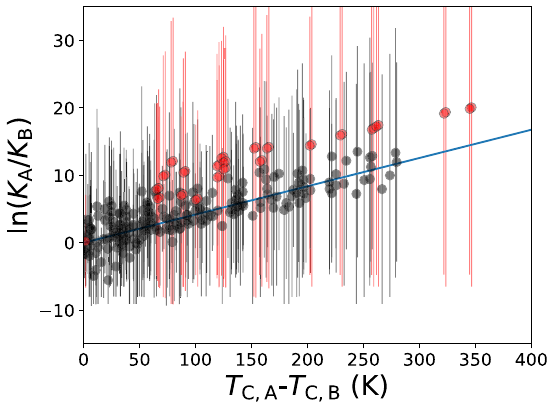
Fig. 7 Correlation for the typical selectivity of binary pairs. Selectivity is calculated as the ratio of Henry ’ s constants obtained from Widom insertion with the critical temperature of each adsorbate (blue). Values shown in red are for adsorbate pairs that contain either octanal or octan-1-ol and have been omitted from the fi tting procedure. The slope of the linear fi t is 0.043 K − 1 with an R 2 value of 0.86. Error bars indicate 95% con fi dence intervals (1.96 standard deviations) from simulations of independent